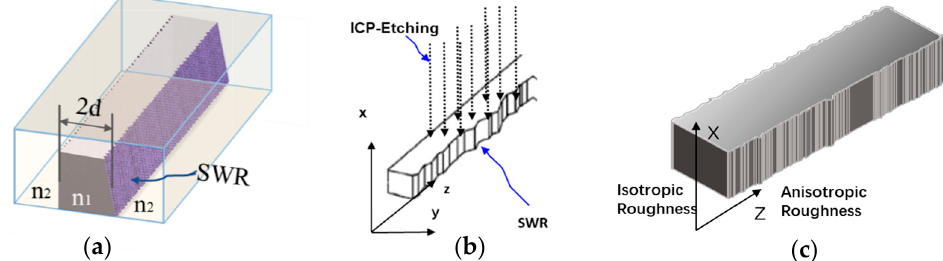
Figure 1. Sidewall roughness (SWR) of silicon-on-insulator (SOI) waveguide: ( a ) the schematic three-dimensional (3-D) equivalent rectangular waveguide with SWR; ( b ) the ICP-etching to a waveguide sidewall; ( c ) the distributions of the SWR at x- and z-coordinate.